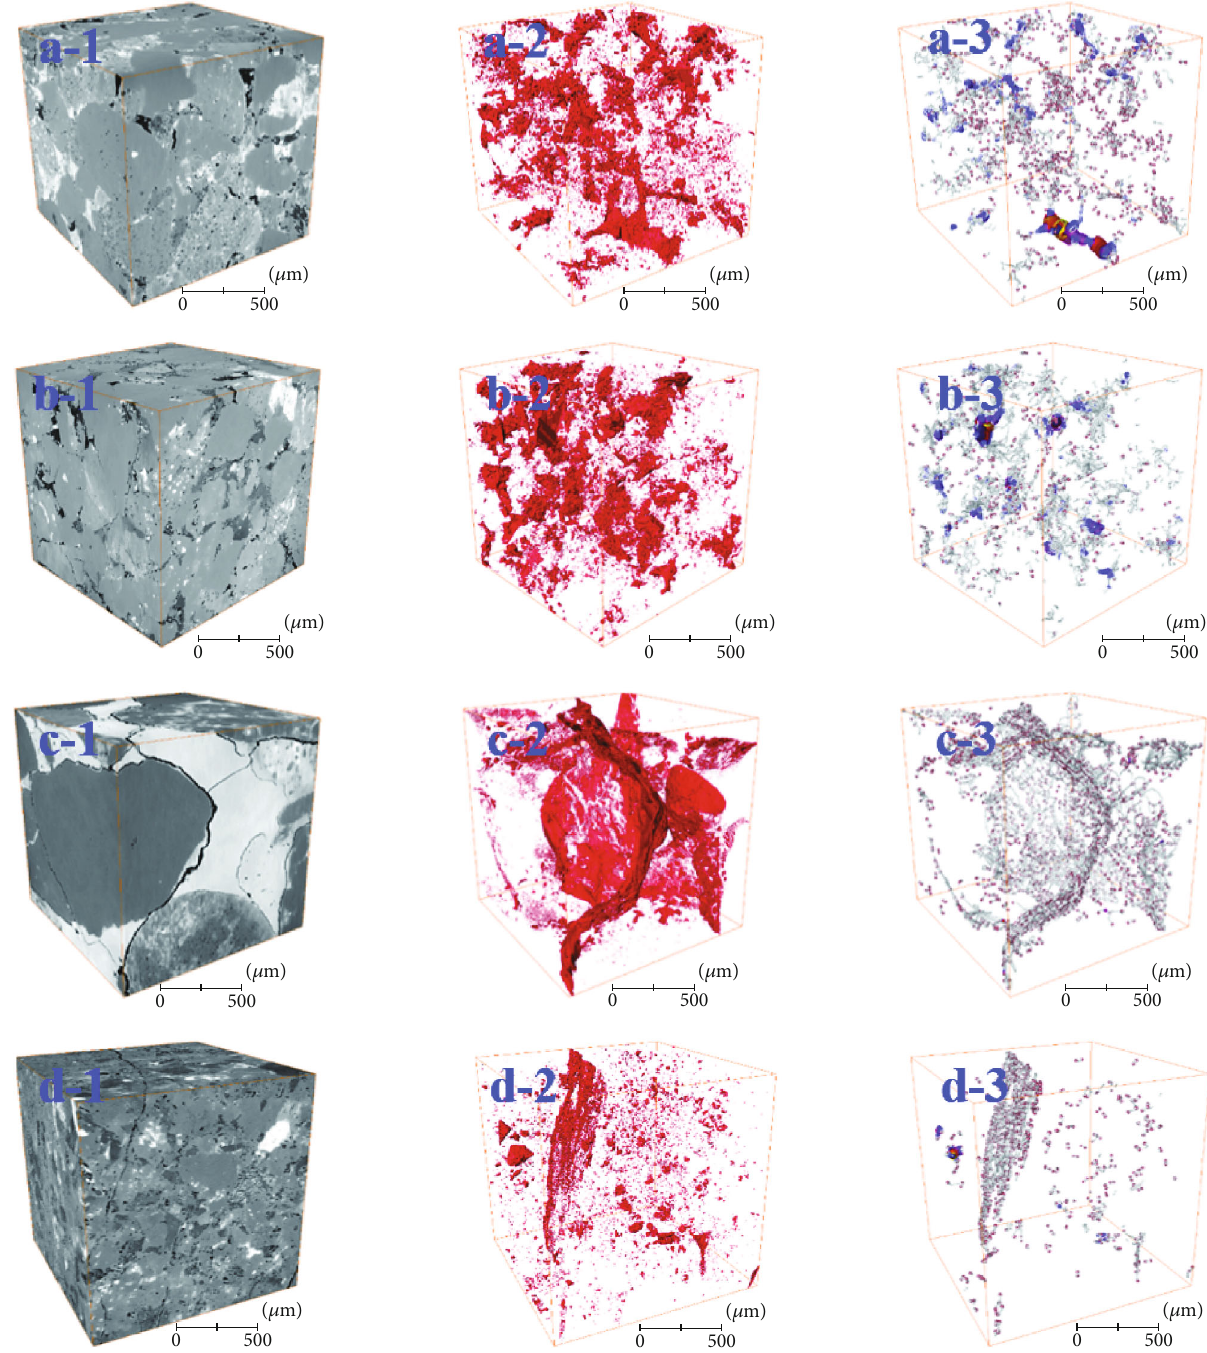
Figure 5: Images showing the microscopic pore structure of some typical sand conglomerate reservoirs in the study area: (a-1 – a-3) micro-CT 3D grayscale model, 3D pore model, and pore network model of reservoir M5-8, which is medium-coarse sandstone; (b-1 – b-3) micro-CT 3D grayscale model, 3D pore model, and pore network model of reservoir M003-4, which is gravel-bearing coarse sandstone; (c-1 – c-3) micro-CT 3D grayscale model, 3D pore model, and pore network model of reservoir M133-7, which is grain-supported conglomerate; (d-1 – d-3) micro- CT 3D grayscale model, 3D pore model, and pore network model of reservoir B64-4, which is matrix-supported